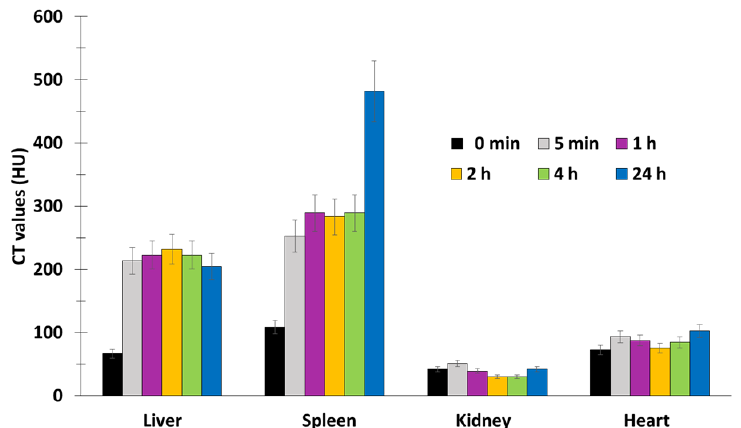
Figure 46. CT values in the liver, spleen, kidney, and heart on BALB/c 5 min post injection of NPs (200 µ L of PEG-capped GdF 3 :Tb 3+ quantified with 20 mg Gd) with different radiation times (X-ray; 136 mGy/4 min). Adapted from Polozhentsev et al.